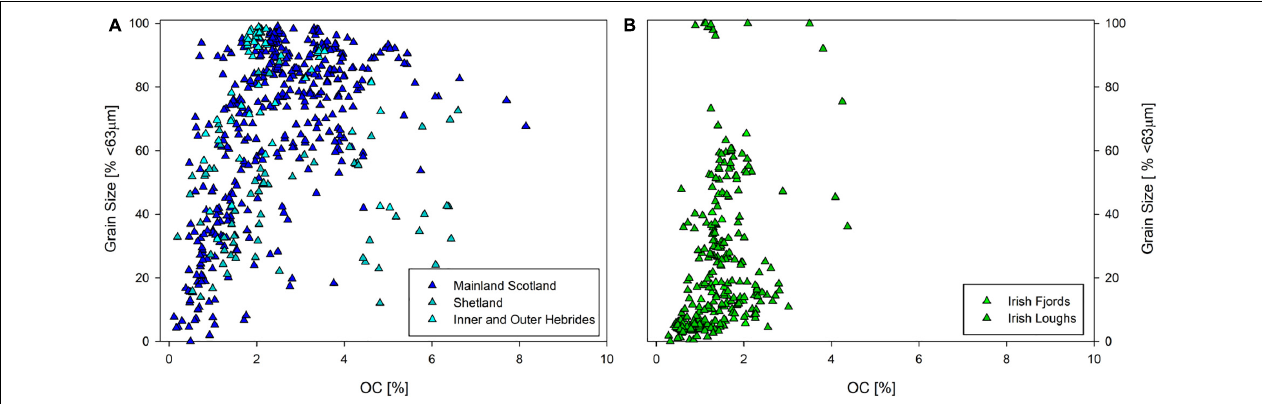
FIGURE 2 | The relationship between grain size (% < 63 µ m) and OC content explored using secondary data (A) Scotland ( n = 670) and (B) Ireland ( n =